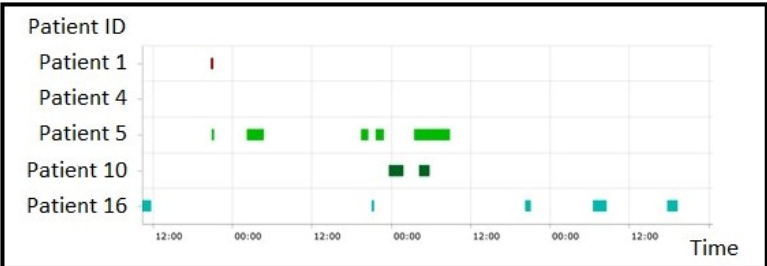
Figure 11. Pattern visualization for a group of Figure 11 . Pattern visualization for a group of patients. Figure 11 . Pattern visualization for a group of patients.